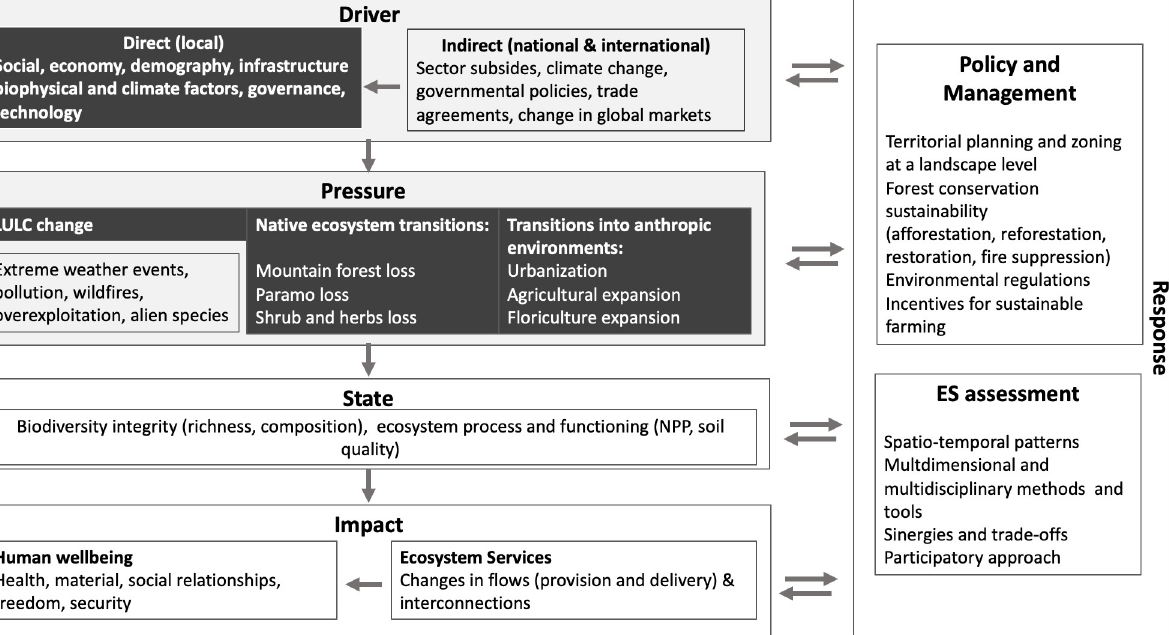
PLOS ONE | https://doi.org/10.1371/journal.pone.0260191 July 27,